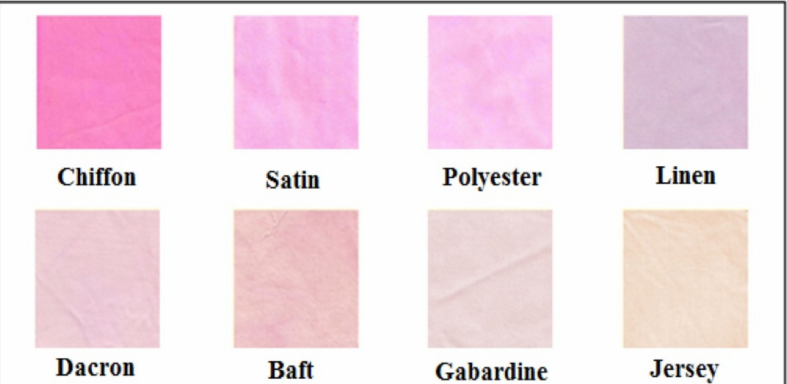
Figure 10. Fabrics of different weaving patterns dyed with Serratia rubidaea RAM_Alex prodigiosin (Reprinted with permission from reference [24]. Copyright 2021